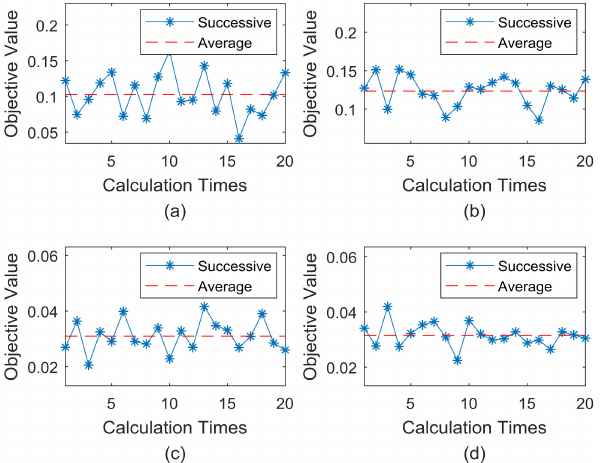
Figure 10. The optimal results after calculating 20 times of the 4 conditions; ( a – d ) correspond to the working Conditions of 1, 2, 3 and 4.